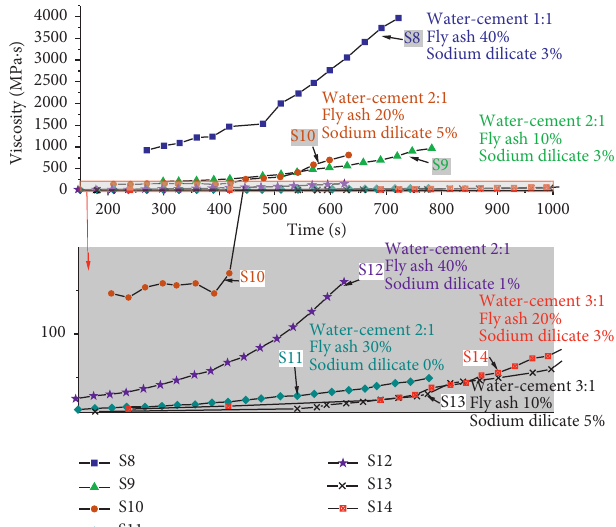
Figure 4: Measured viscosity